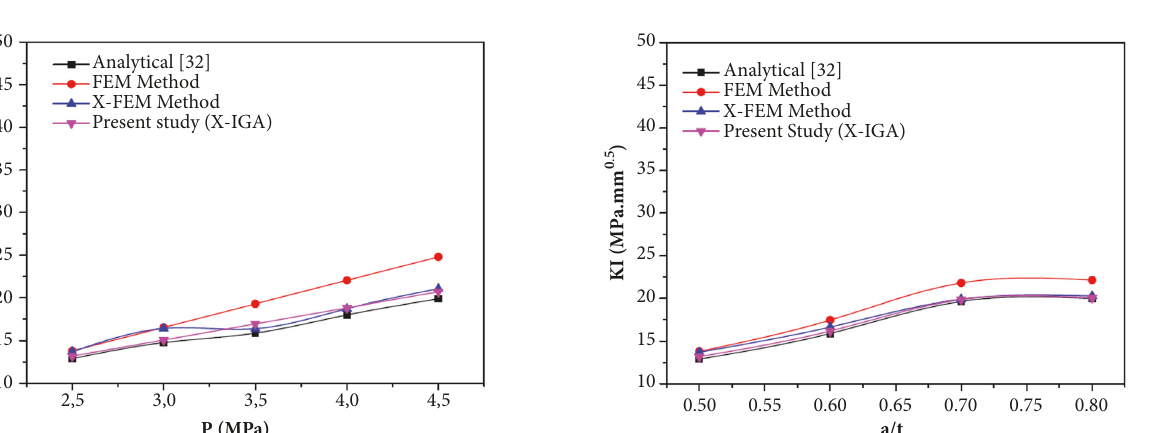
Figure 4: The von Mises stress for the case of X-IGA, X-FEM, and FEM.